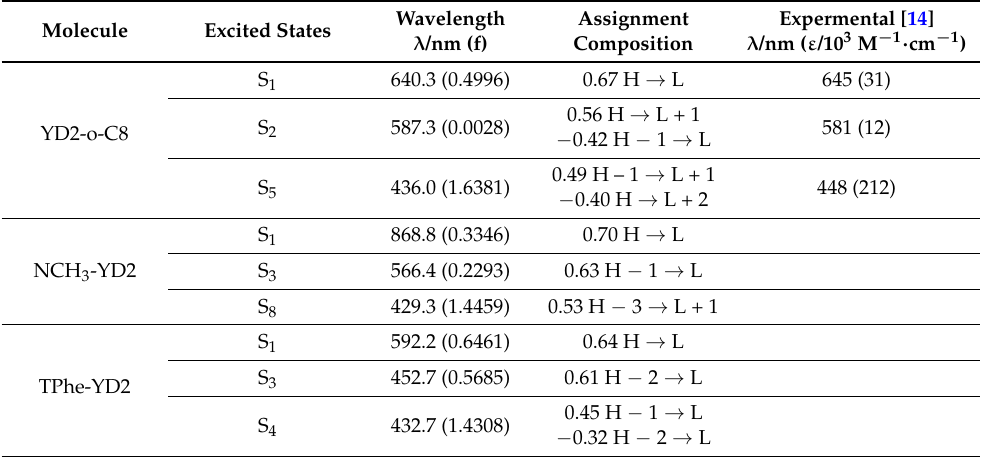
Table 4. The calculated absorption spectra, oscillator strength (f), and nature of the transitions, together with available experimental values